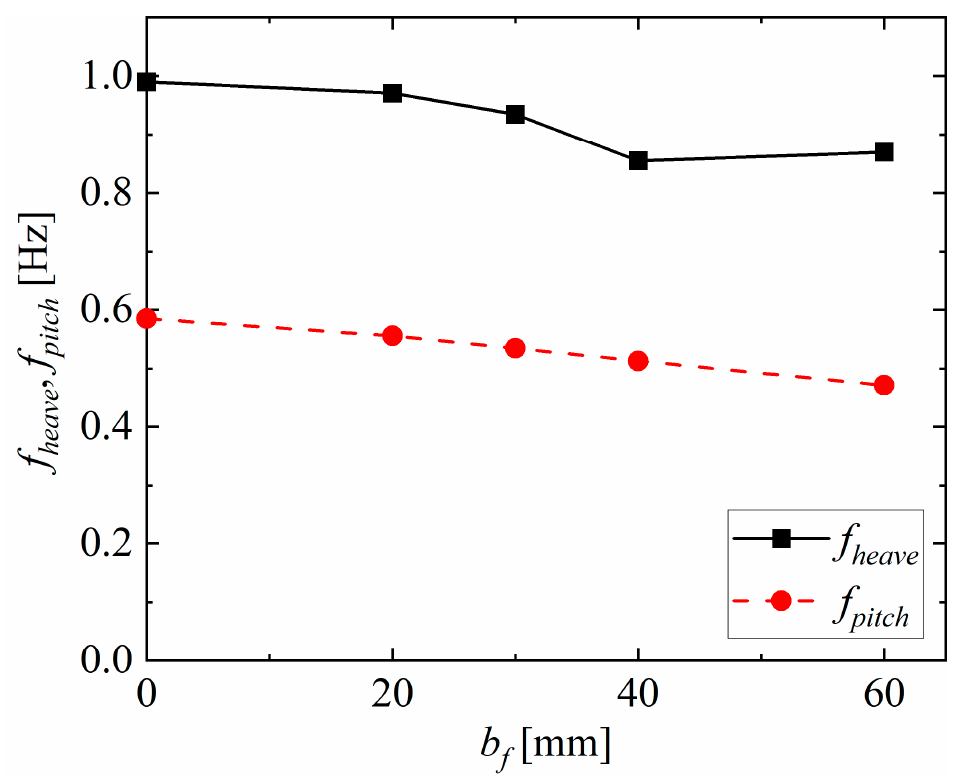
Figure 5. Natural frequency of the heave f heave and pitch f pitch of the caisson.